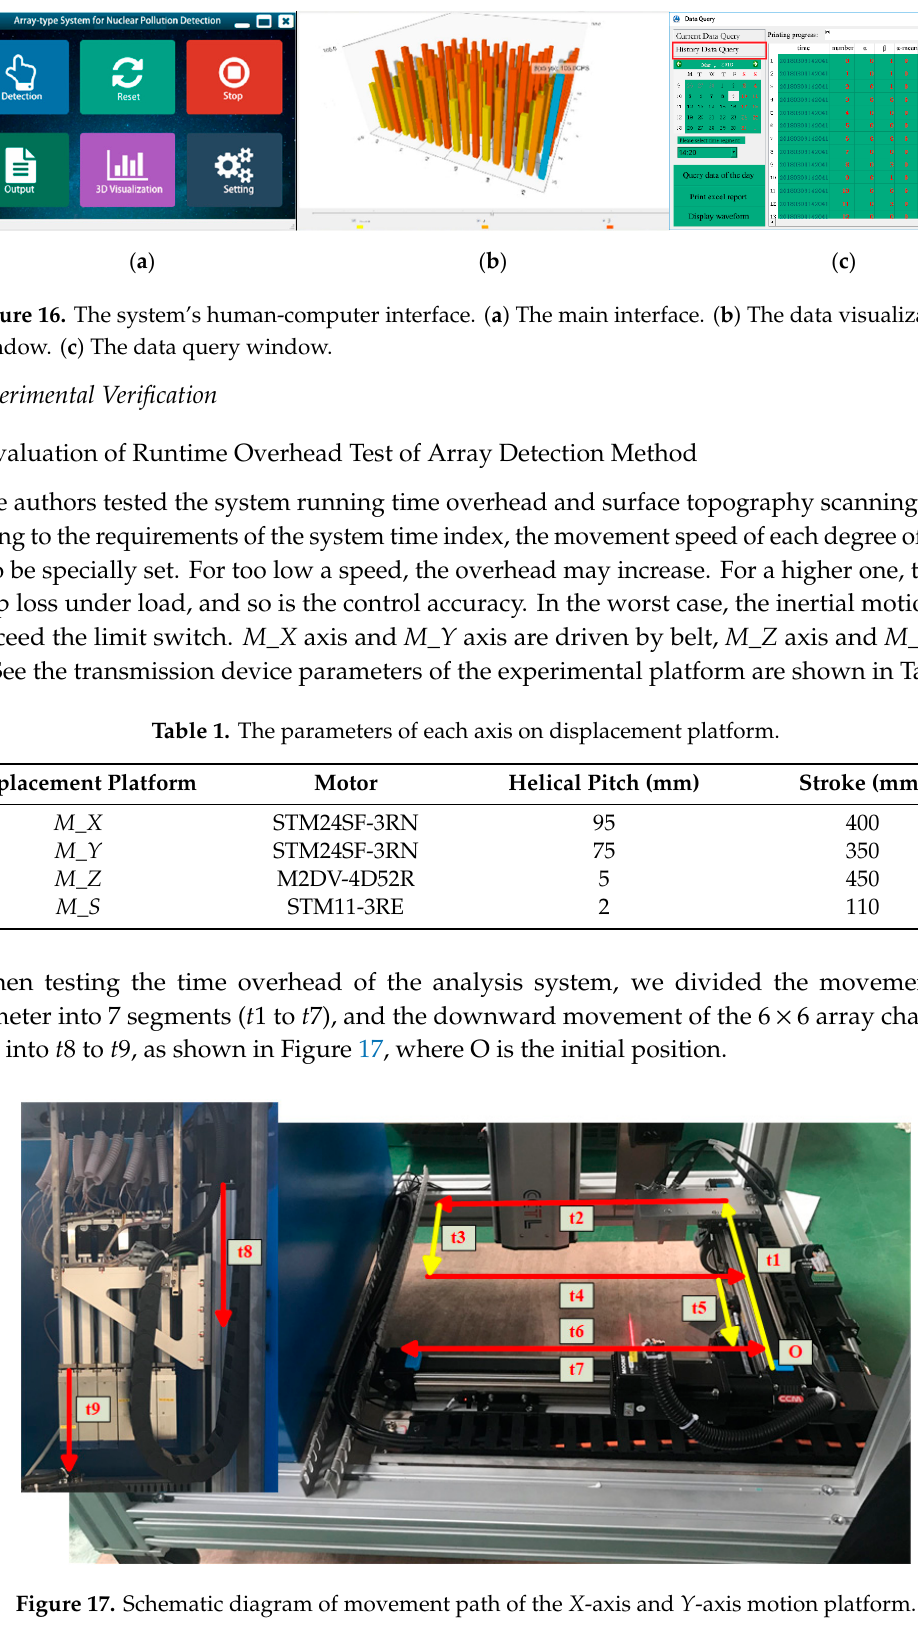
Figure 17. Schematic diagram of movement path of the X -axis and Y -axis motion platform.